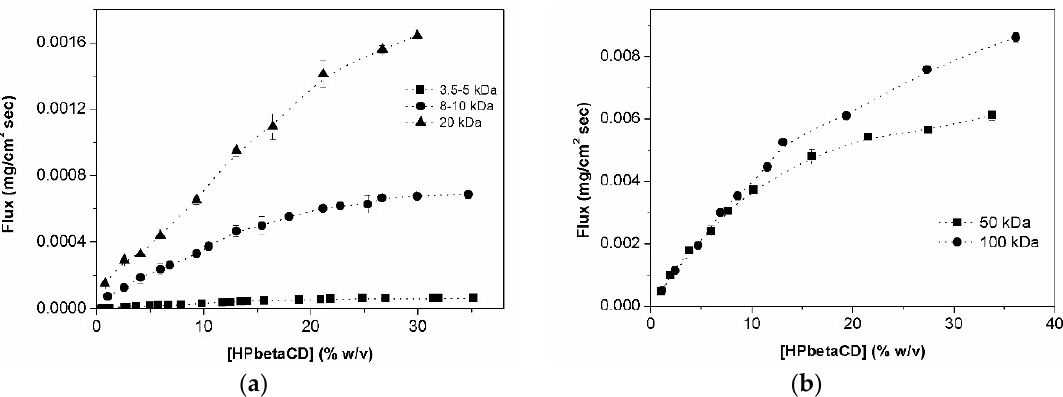
Figure 6. Flux profile of HPβCD through semipermeable membranes: 3.5–5, 8–10, and 20 kDa ( a ) and 50, 100 kDa ( b ) at room temperature (about 23 °C).